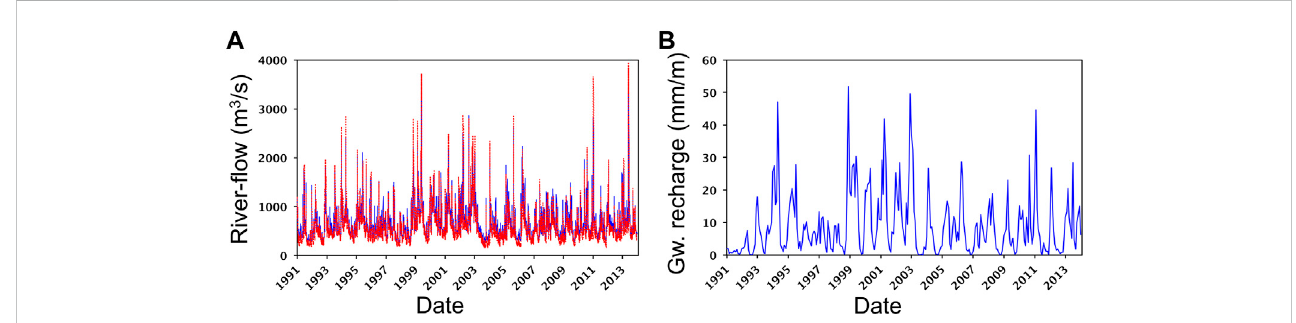
FIGURE 3 (A) Fittingbetween thecomputed(reddashedline)andthemeasured(blueline)river fl owrateattheoutletofthebasin(from01/01/1991to31/12/2013);